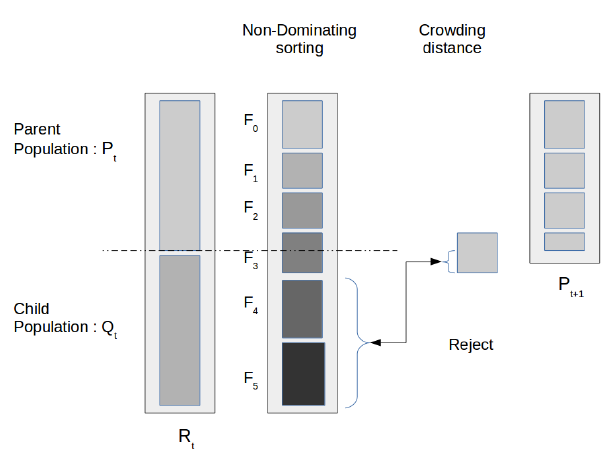
Figure 2. Population